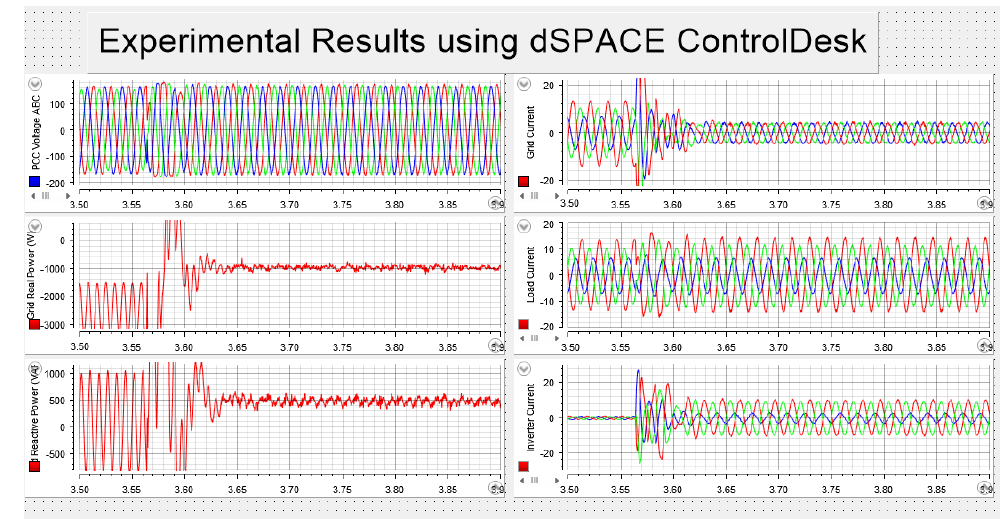
Figure 16. Experimental results at P = − 1 kW, Q = 500 var using dSPACE Control